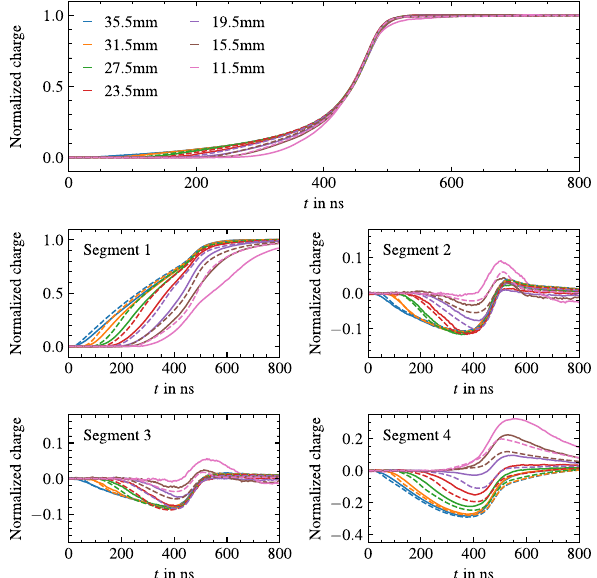
Fig. 17 Superpulses of events assigned to interaction points on the (cid:4) 100 (cid:5) axis in segment 1 of the segBEGe detector at φ = 46 . 1 ◦ , z = 20mm and different r as given in the legend at a detector temper- ature of 78K. The solid lines depict Compton superpulses determined as described in Sect. 5.3. The dashed lines depict pulses simulated with SolidStateDetectors.jl [17].Forthesimulation,theimpuritydensitywas set to 90% of the values given by the manufacturer [36]. The preampli- fier bandwidths and contributions from linear and differential cross-talk were added to the pulses [37]. All pulses are time-shifted such that the core pulses are aligned to 70% of their